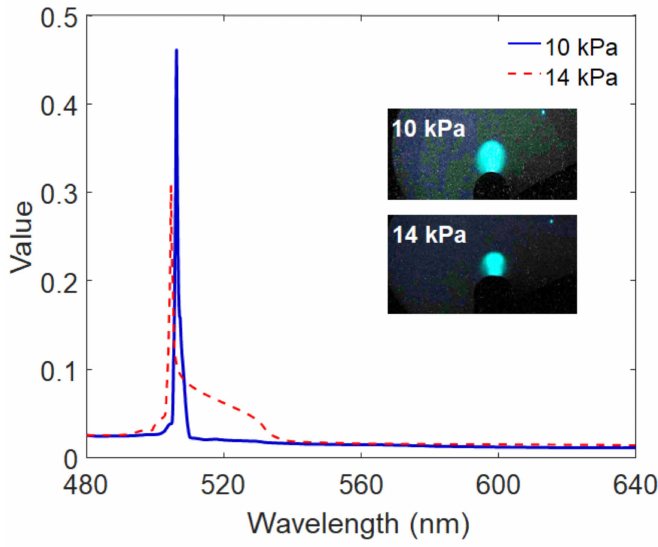
Figure 11. Example of spectra illustrating the intraocular pressure (IOP) monitoring principle based on a mechanoluminescent optomechanical sensory system (inset: captured ML images for di ff erent